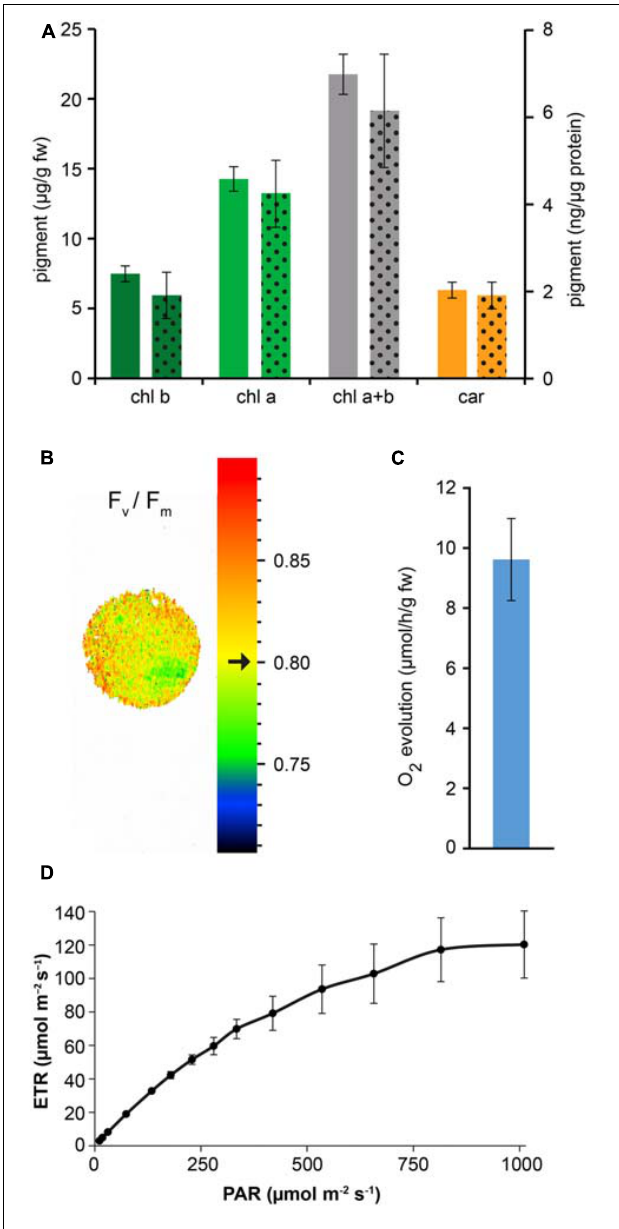
FIGURE 5 | Measurement of photosynthetic pigment content and photosynthetic activity of Arabidopsis cell suspension cultures. (A) Quantitative analysis of chlorophyll b (chl b), chlorophyll a (chl a) and total carotenoids (car). Full column values refer to the y axis on the left, dotted column values refer to the y axis on the right. Data are the means ± SE ( n = 5). (B) PAM imaging analysis demonstrated a very good maximum quantum yield of photosystem II. Black arrow indicates a F v /F m mean value of 0.80 ± 0.01 ( n = 3), representative for the displayed sample spot. (C) Quantitative analysis of O 2 evolution. Data are the means ± SE ( n = 8). (D) Electron transport rate (ETR) at PSII. Data are the means ± SE ( n =